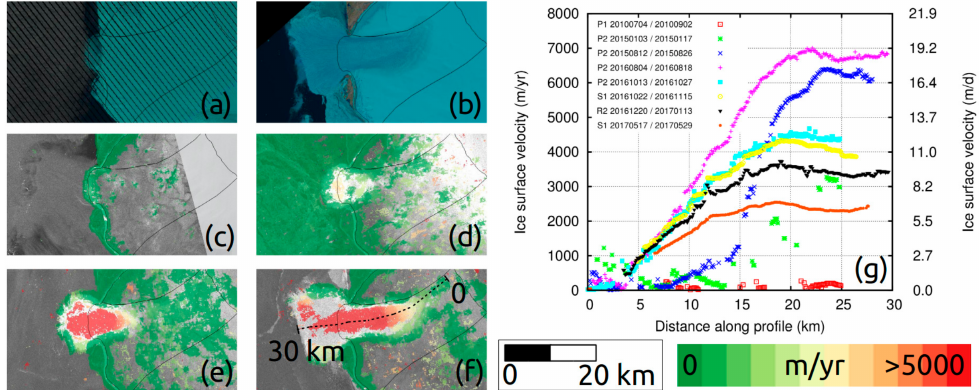
Figure 15. Vavilov Ice Cap (Severnaya Zemlya): satellite optical images from Landsat-7 on 07-09-2010 ( a ) and Landsat-8 on 15-07-2016 ( b ), ice surface velocity maps from ALOS-1 PALSAR-1 in 2010 ( c ), ALOS-2 PALSAR-2 in January 2015 ( d ), ALOS-2 PALSAR-2 in August 2015 ( e ) and ALOS-2 PALSAR-2 in August 2016 ( f ), and time-series of surface displacements on a profile along the centre flow-line of the glacier from ALOS-1 PALSAR-1 (P1), ALOS-2 PALSAR-2 (P2), Sentinel-1 (S1) and Radarsat-2 (R2) data ( g